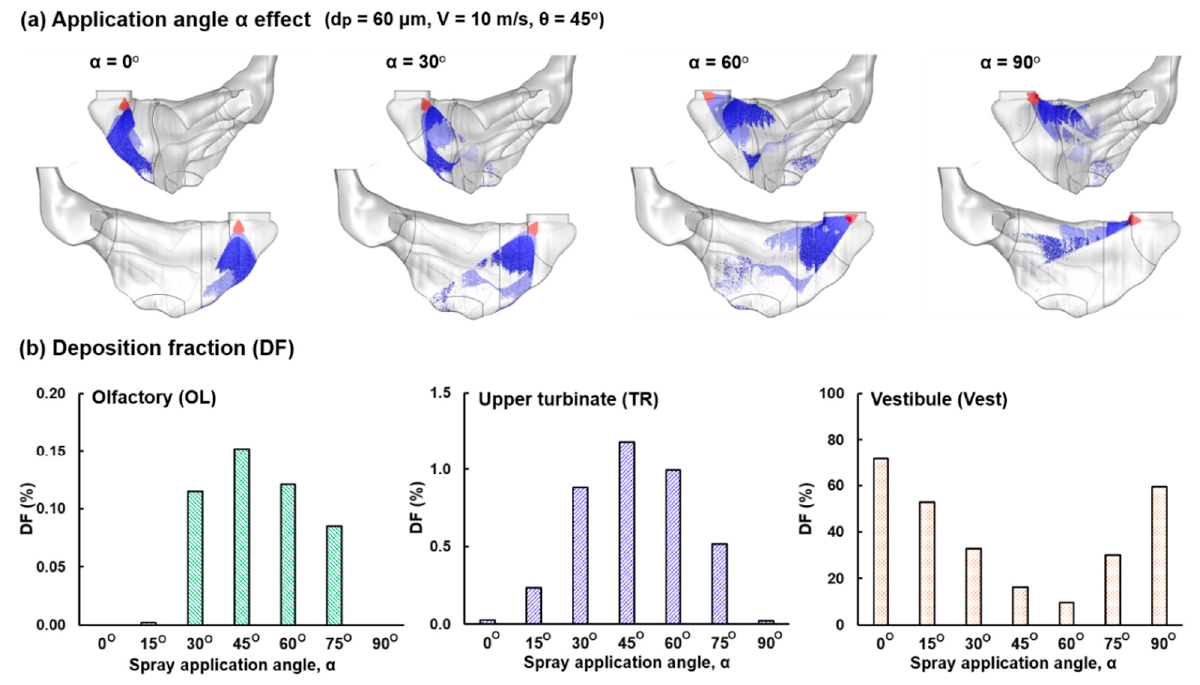
Figure 6. Application angle ( α ) effect with a spray release position at L2b (a 4 mm insertion from nostril base): ( a ) deposition distributions for α = 0° (vertical), 30°, 60°, and 90° and ( b ) subregional DFs in the OL, upper TR, and Vest vs. α .